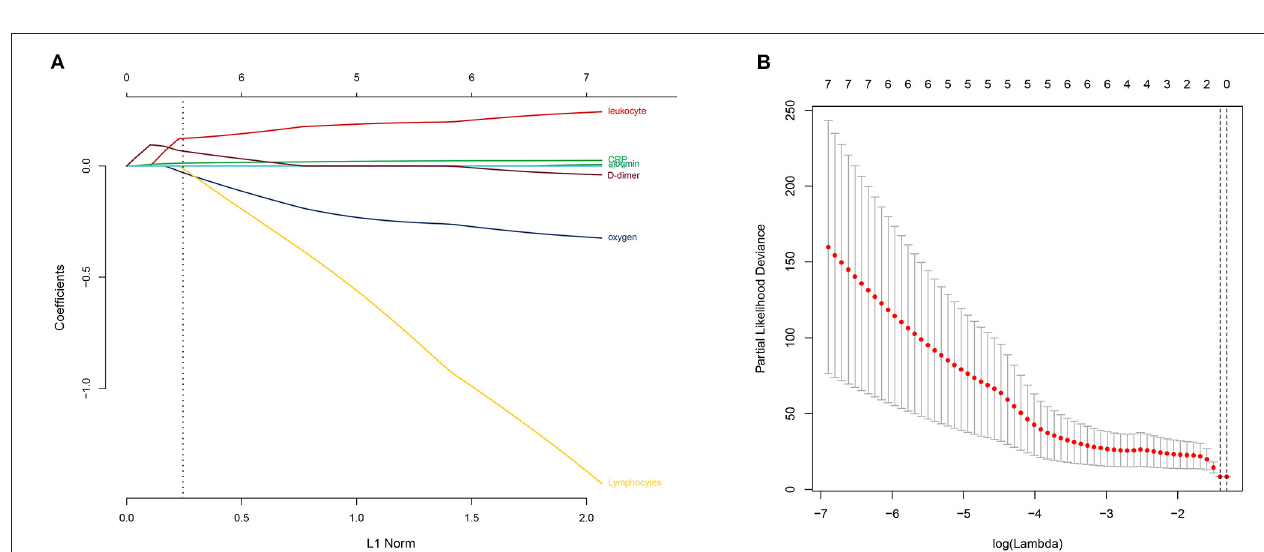
FIGURE 5 | Selection of the prognostic signature using the least absolute shrinkage and selection operator (LASSO) analysis in the training dataset. (A) The LASSO coefficient spectrum of the indicators of COVID-19. (B) Selecting the best parameters for COVID-19 in the LASSO model ( λ ).